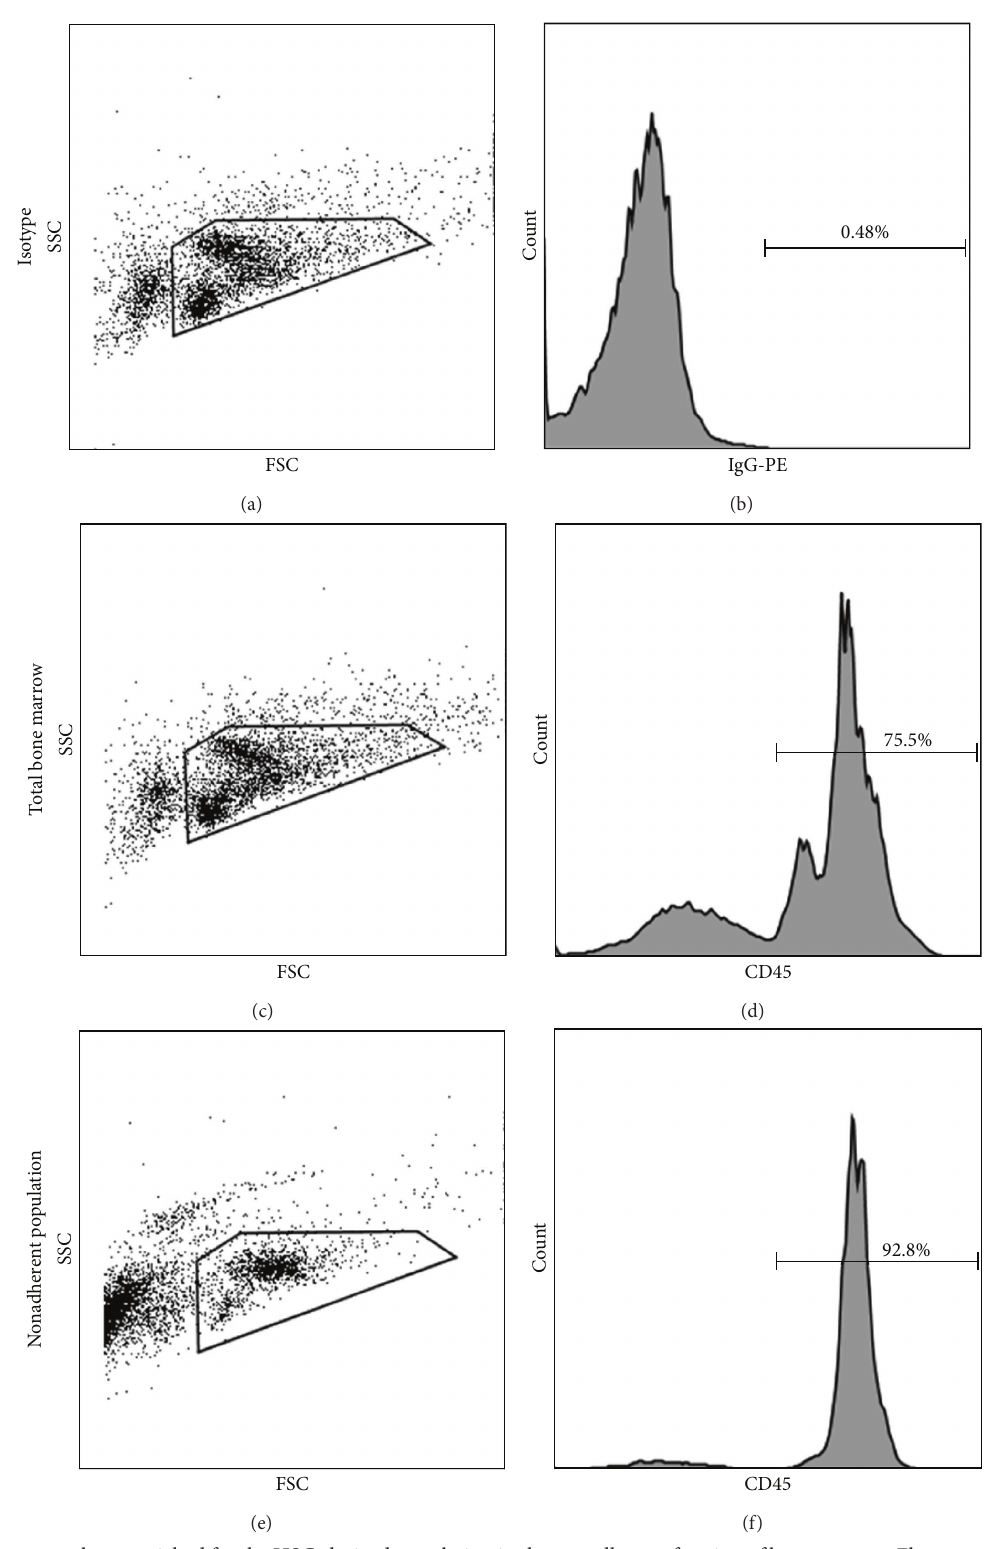
Figure 1: Adherence culture enriched for the HSC-derived population in the nonadherent fraction of bone marrow. Flow cytometric analysis of CD45 expression in total bone marrow was compared to that in the 96-hour nonadherent bone marrow population. A representative analysis is shown. Panel (a) shows forward and side scatter gate and Panel (b) shows isotype control for CD45 staining gated on the live, propidium iodide (PI) negative population. A representative analysis of CD45 expression by total bone marrow is shown where Panel (c) depicts the forward and side scatter gate and Panel (d) shows CD45 staining gated on the live, PI negative population. Panel (e) depicts the forward scatter and side scatter gate for the nonadherent bone marrow fraction, and Panel (f) shows the CD45 staining gated on the live, PI negative